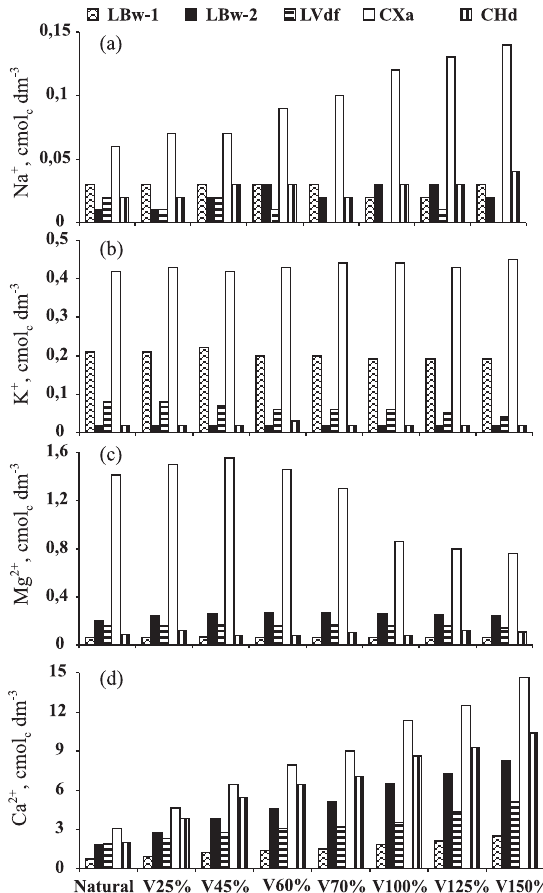
Figura 1. Teores de Na, K, Mg e Ca trocáveis em função de aplicação de doses de CaO aplicadas para V calculado de 25, 45, 60, 70, 100, 125 e 150